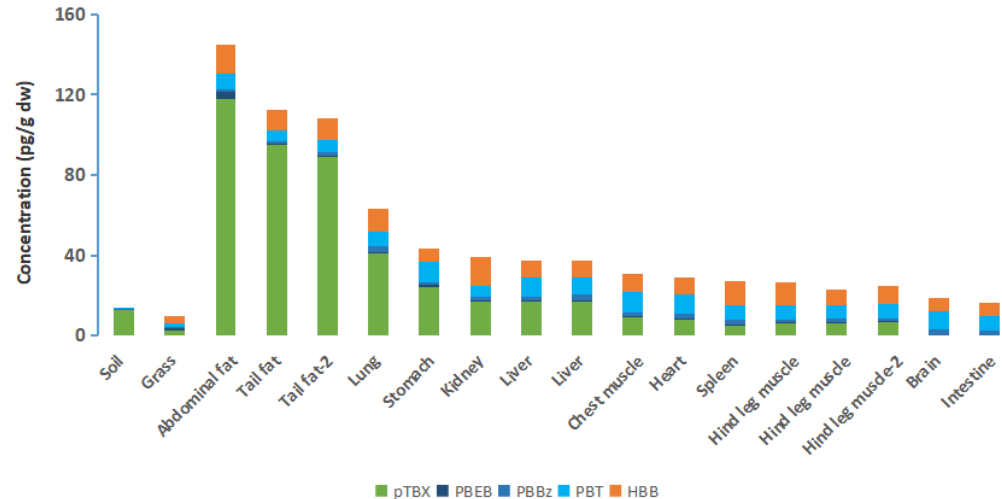
Figure 5. Novel brominated flame retardant concentrations in the different organs and tissues of sheep from Inner Mongolia grassland, China.